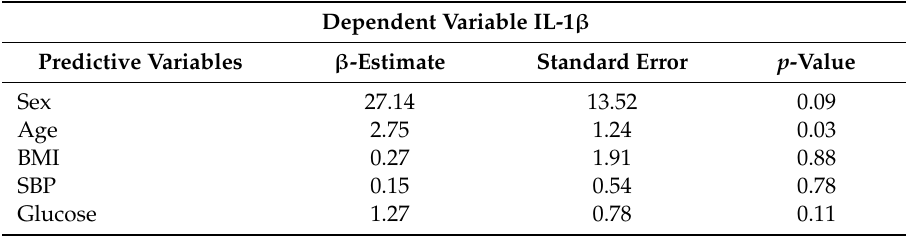
Table 5. Association of sex with proatherogenic cytokines in the entire patient cohort.